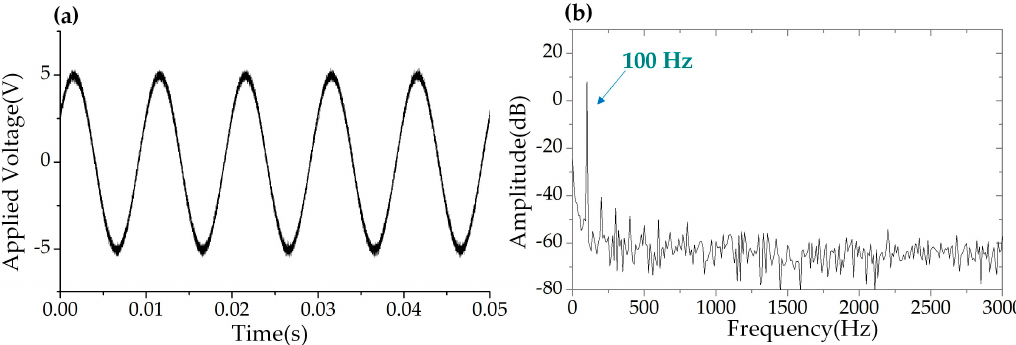
Figure 10. The driven signal applied to the piezoelectric transducer (PZT) stage. ( a ) The waveform in time domain. ( b ) The power spectral density of the FFT spectrum of ( a